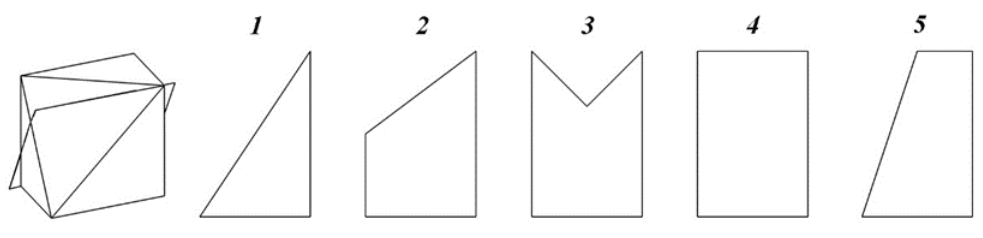
Figure 1. Mental Cutting